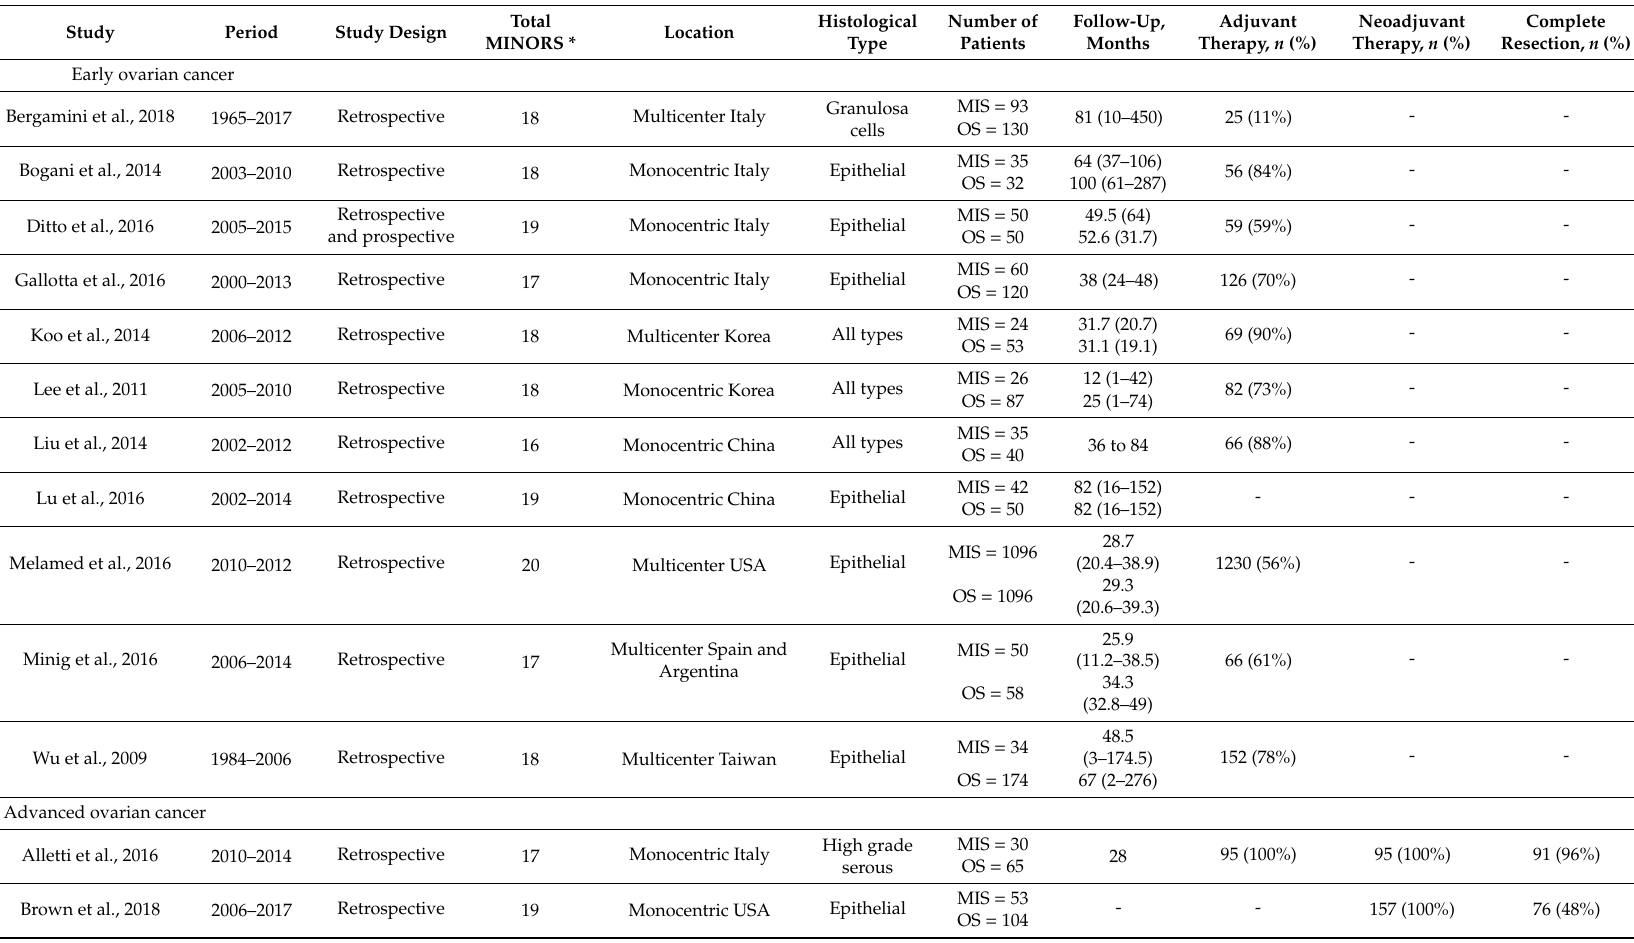
Table 1. Study design and demographic